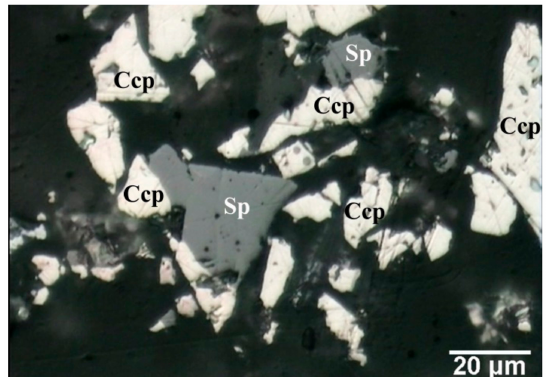
Figure 2. Optical micrograms of the chalcopyrite concentrate sample